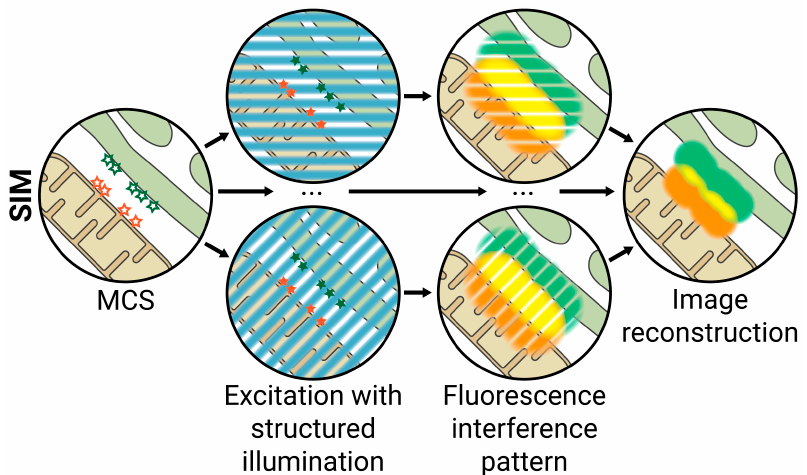
Figure 3. Structured Illumination Microscopy (SIM). The sample is excited by a grid-like patterned light with alternating bands of high and low intensity. This patterned excitation interferes with var- iations in fluorophore density and creates interference patterns that can be used to extract infor- mation about the probe density. The excitation light is rotated, and several interference patterns are combined to reconstruct a super-resolved image. Lateral resolution ≈ 100 nm; axial resolution ≈ 300 nm.